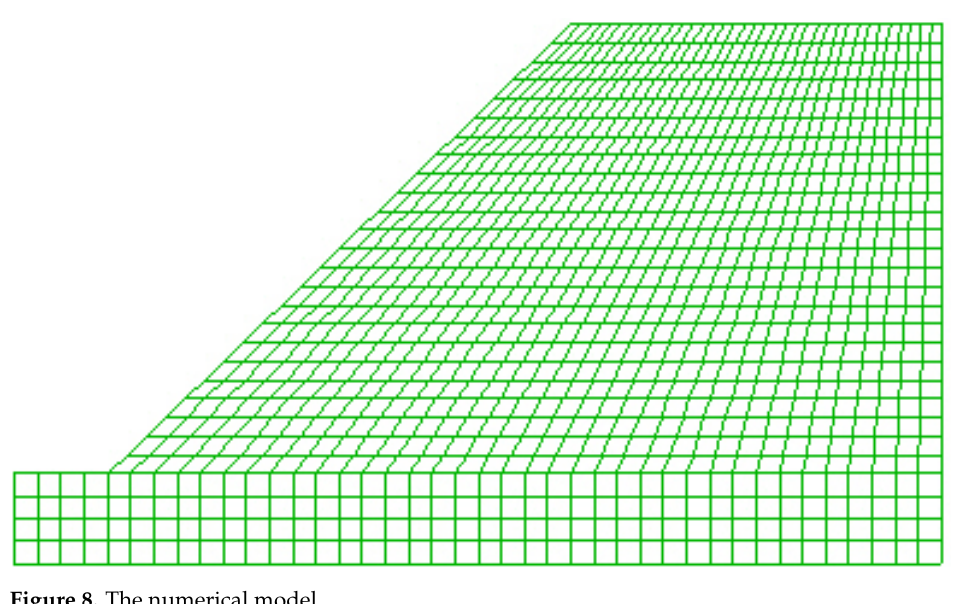
Figure 8. The numerical model.